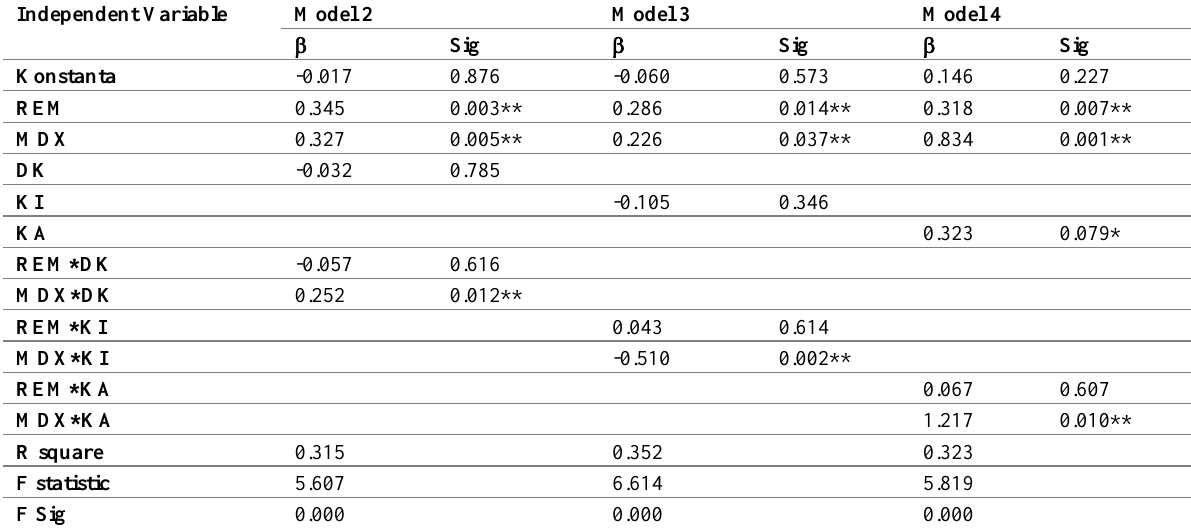
Table 4: Test Model 2,3,4 with Moderated Regression